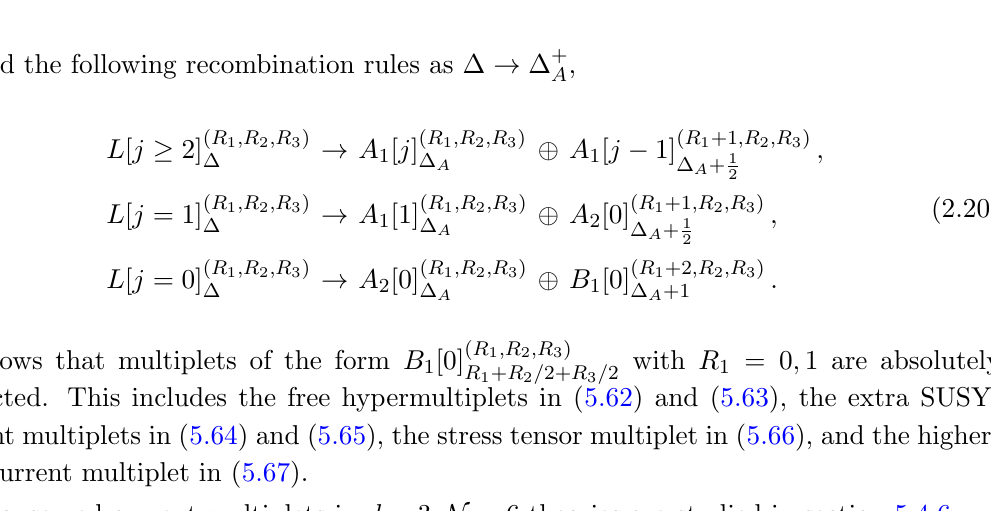
Table 8 . Shortening conditions in three-dimensional N = 6